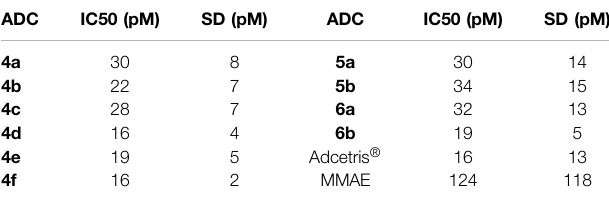
andMMAEinKarpas-299cells.AverageIC50(mean)andstandarddeviations (SD) were determined from n ≥ 2